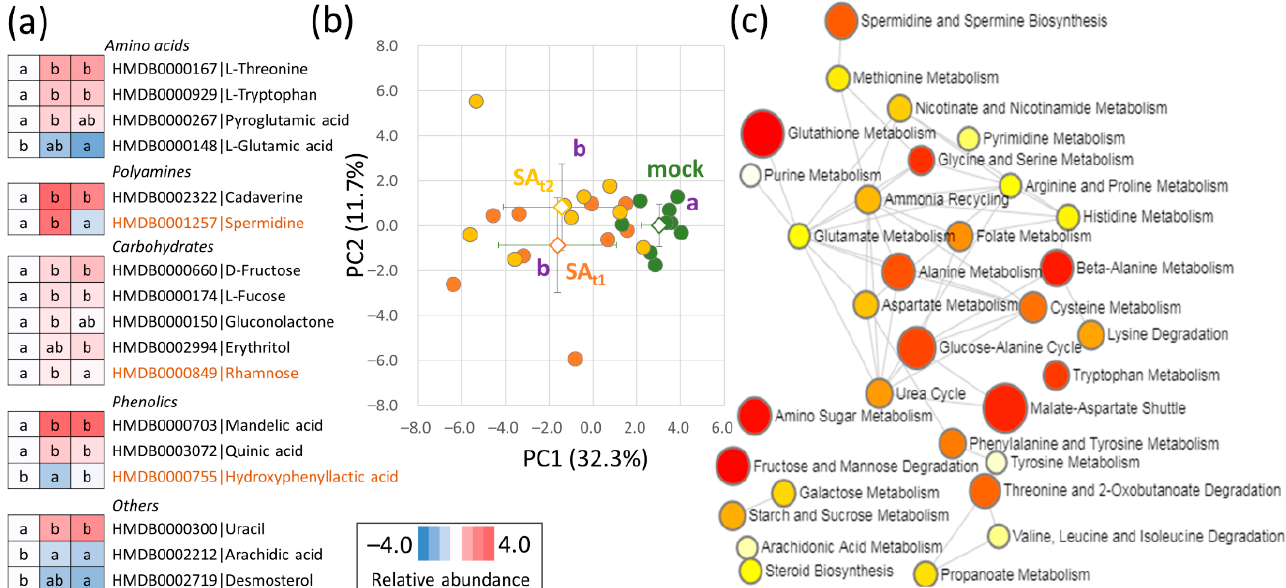
Figure 6. Differentially abundant metabolites in seeds of plants treated with salicylic acid. ( a ) Heat maps represent the mean relative abundances of nine biological replicates; letters represent the results of Kruskal-Wallis and Conover’s test ( p < 0.05); orange, SA t1 -specific effect; ( b ) PCA based on the profile of all differentially abundant metabolites (Student’s t -test, p < 0.05). Open shapes and dot lines represent means and standard deviations, respectively. The letters represent significant differences ( p < 0.05, Kruskal–Wallis and Conover’s test, p < 0.05); ( c ) Enrichment analysis of metabolic pathways by MetaboAnalyst. Size and red color intensity indicate pathway significance. For details, see Supplementary Table S3.